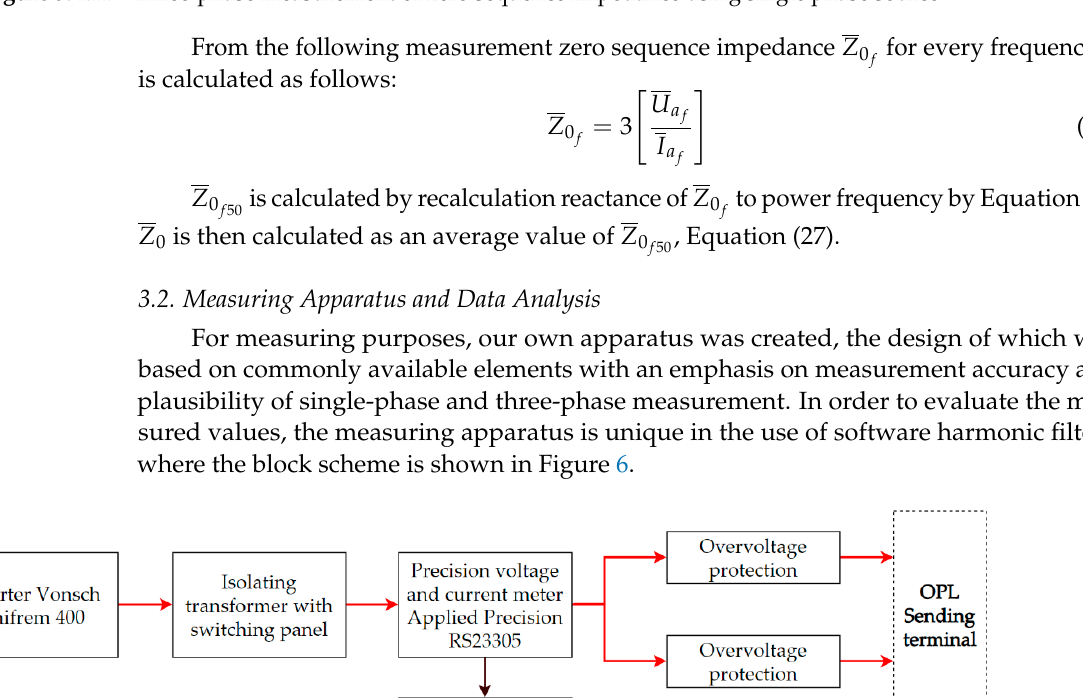
Figure 5. M4—Three-phase measurement of zero sequence impedance using single phase source.